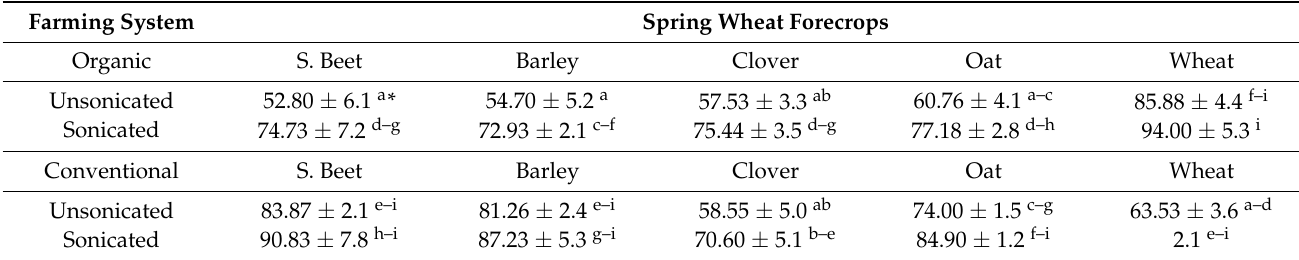
Table 11. Wheat gluten surface advancing contact angles